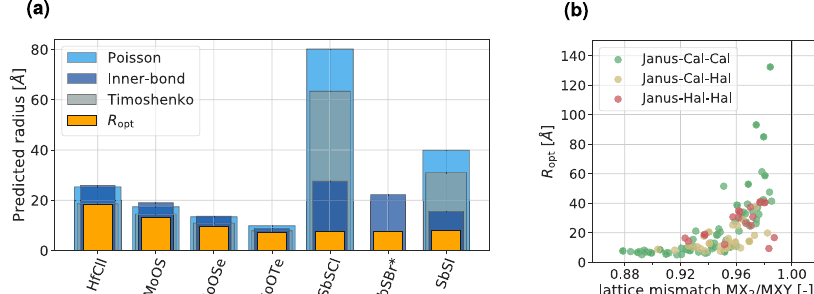
Fig. 7 Optimal radius descriptors. a Optimal tube radius using the three models based on the Timoshenko plate theory 34 , considering the Poisson ratios (Poisson) 15 and using lattice mismatches between Janus MXY and MY 2 parent sheets (Inner-bond model). The optimal radius based on DFT calculations R opt is also shown which has been obtained extrapolating the function given in Eq. (2). The asterisk indicates that due to prototype changes when straining the SbBr 2 sheet, it was not possible to get the elastic tensor required for the Timoshenko and Poisson model. b The radius plotted against the lattice mismatch MX 2 /MXY.